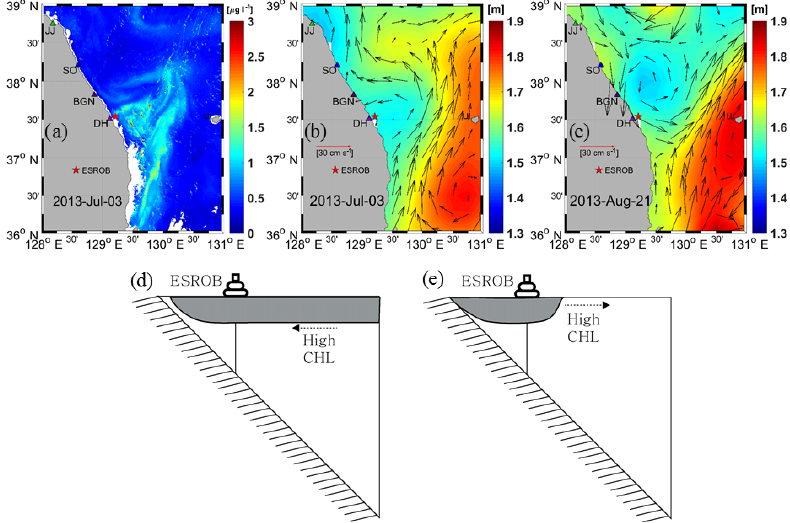
Figure 9. Distributions of (a) daily composite of chlorophyll a concentration in 3 July 2013, obtained from the GOCI, and satellite-altimetry- derived surface geostrophic currents in (b) 3 July and (c) 21 August 2013. Schematics for (d) on-shore and (e) off-shore advection of high CF surface water for 3 July (E07) and 21 August 2013 (E10).